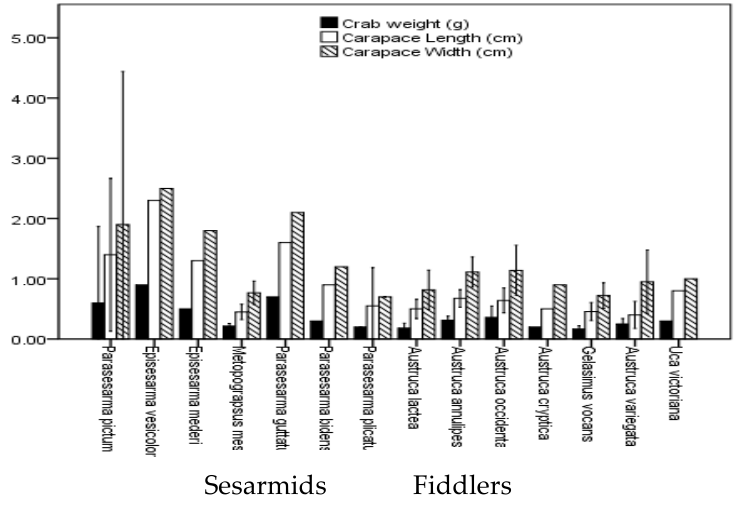
Figure 3. Crab weight, carapace width and length in 14 burrowing crab species; values significant between crab species at 1% level.